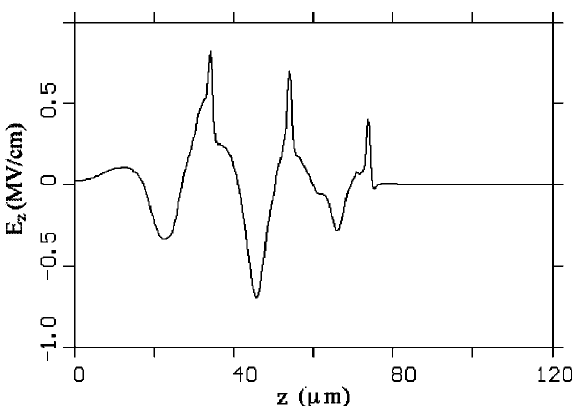
FIG. 7. (Color) Superposition of axial field E three bunches at 250 fs after entry of the first bunch into the structure. It is seen that the fields of the three bunches add at the third bunch position (see Fig. 9).